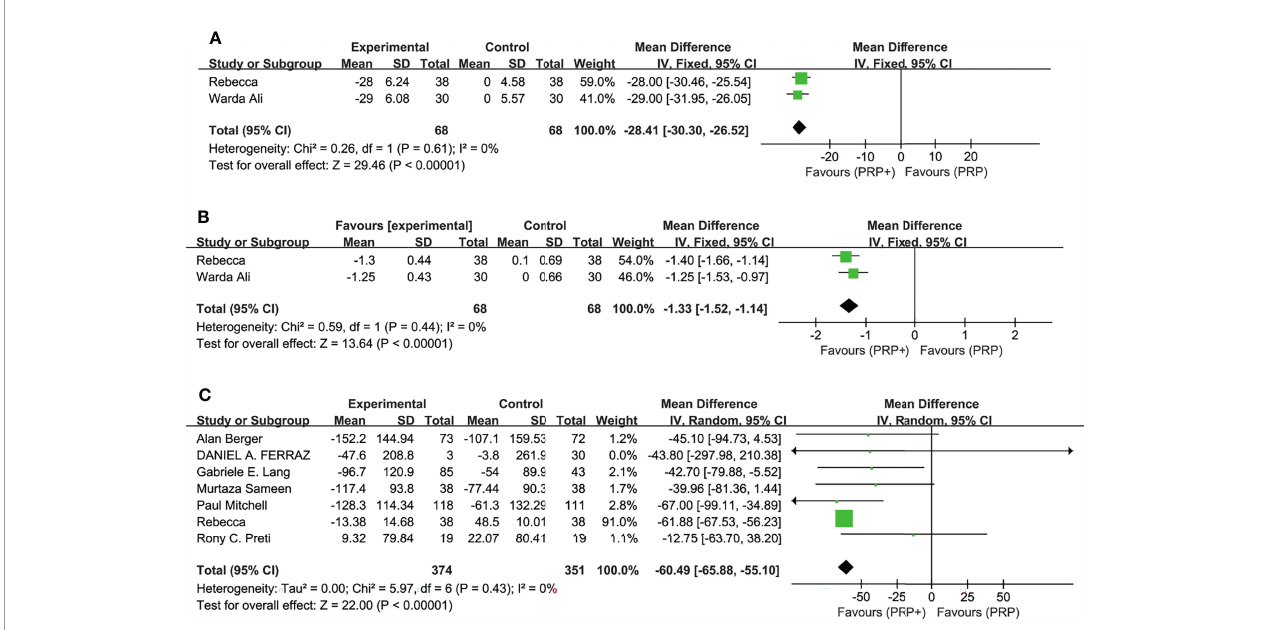
FIGURE 4 | Meta-analyses of PRP+anti-VEGF treatment and PRP monotherapy, comparing changes of NVD (DD%), NVE (DD), and CMT ( m m). (A) NVD (DD%), (B) NVE (DD), and (C) CMT ( m m). Outcomes assessed: NVD, NVE, and CMT in studies that compared combination treatment with PRP monotherapy. The shaded area is the weight of the estimate in proportion to the overall effect.